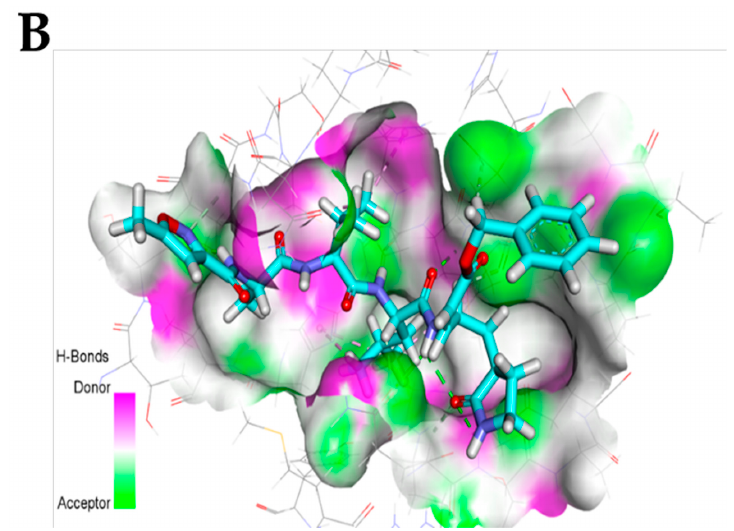
Figure 3. ( A ) Co-crystallized ligand (PRD_002214) docked into the active site of COVID-19 main protease. ( B ) Mapping surface showing co-crystallized ligand (PRD_002214) occupying the active pocket of COVID-19 main protease.